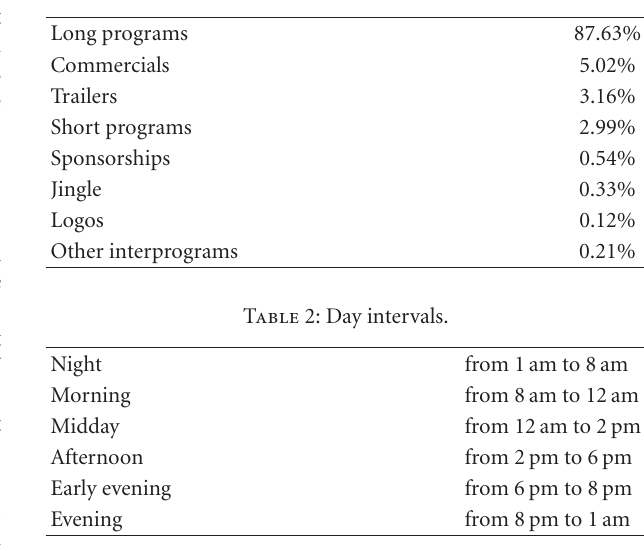
Table 1: Composition of TVTrain .